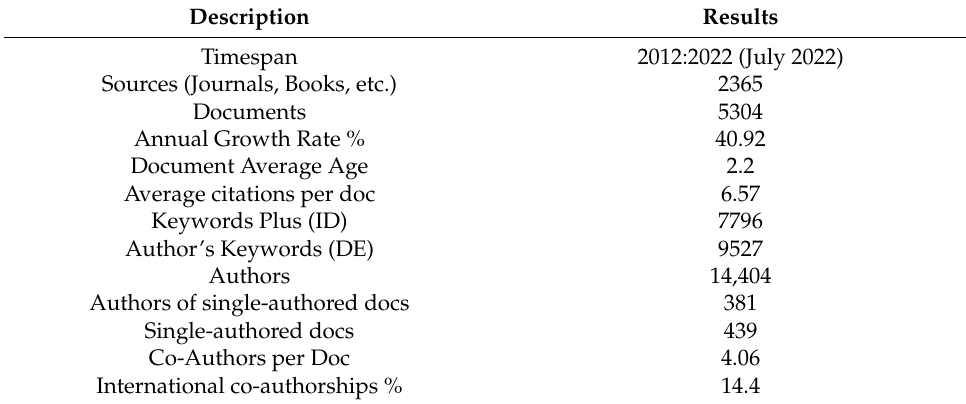
Table 2. Overview of the final dataset used for bibliometric